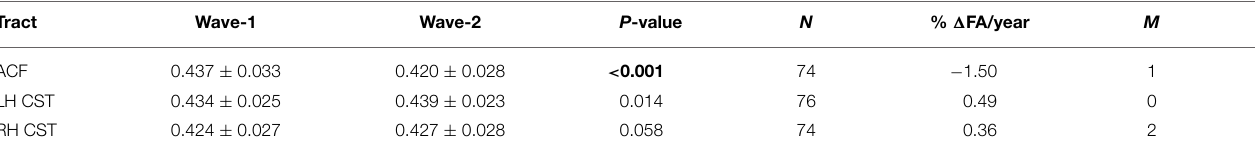
TABLE 6 | Mean and standard deviation of tract mean FA in the anterior callosal fiber (ACF) bundle, and in left and right hemispheres (LH, RH) of the corticospinal tract (CST) at baseline (Wave-1) and at follow-up 3 years lager (Wave-2). Tract